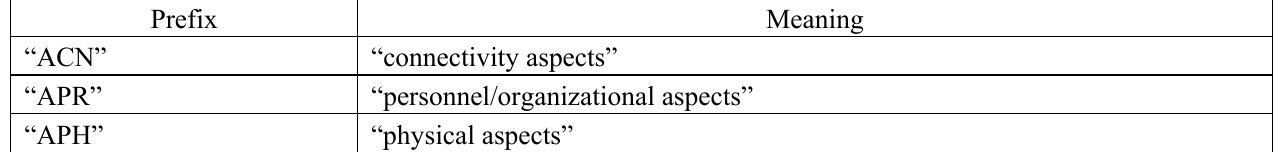
Table 5. Family field concerning assumptions.